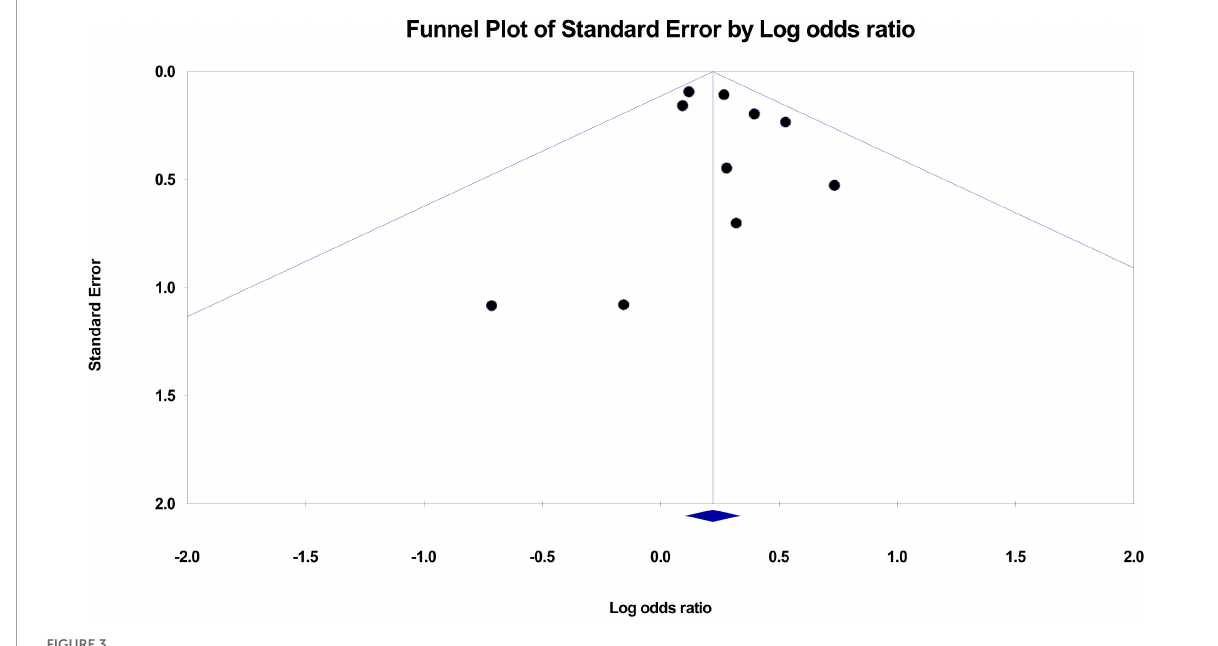
FIGURE3 Funnel plot demonstrating risk of publication